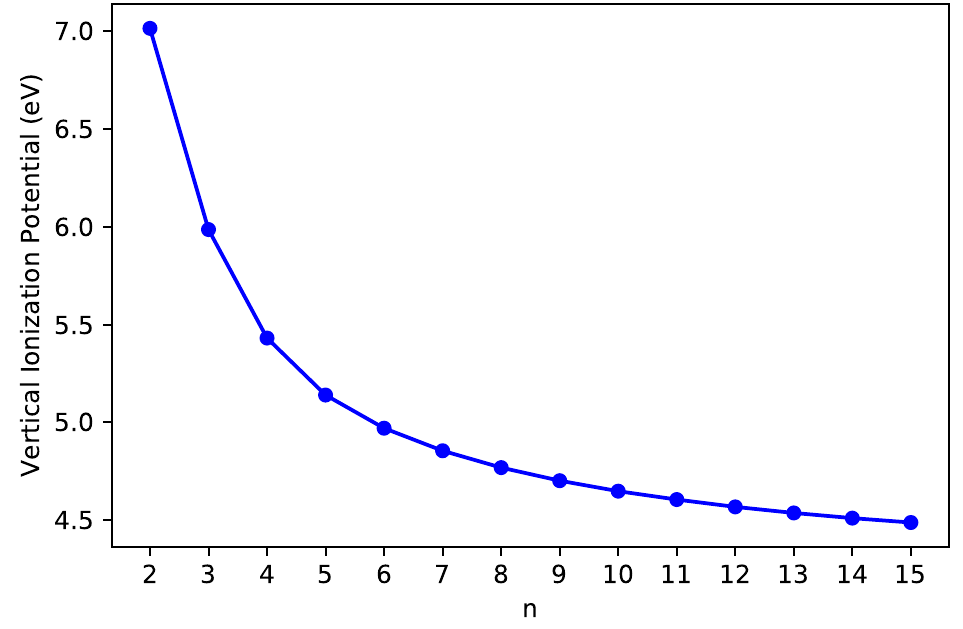
Figure 3. Vertical ionization potential of ground-state n -pyrene, calculated by spin-unrestricted